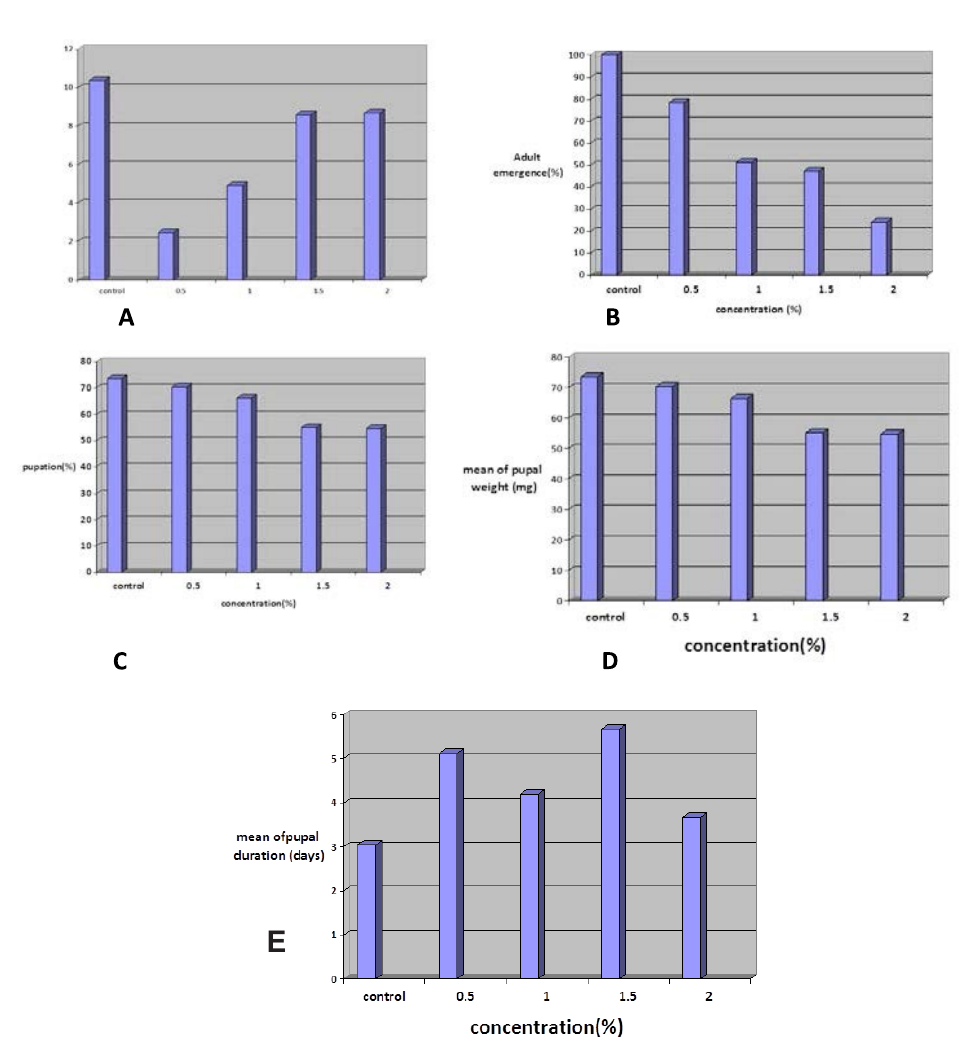
A: Fig. 2. Effect of Different Concentrations of Bacillus thruingiensis israelensis on Larval Life Span ( Days ) of M. Domestica Treated as 2 nd Larval Instar. B: Fig. 3. Effect of Different Concentrations of Bacillus thrringiensis israelensis on the Percentage of Pupation of M. domestica Treated as 2 nd Larval Instar. C: Fig. 4. Effect of Different Concentrations of Bacillus thuringiensis israelensis on the Percentage of Pupation of M. domestica Treated as 2 nd Larval Instar. D: Fig. 5. Effect of Different Concentrations of Bacillus thuringiensis israelensis on Mean of Pupation Weight (mg) of M. domestica Treated as 2 nd Larval E: Fig. 6. Effect of Different Concentrations of Bacillus thuringiensis israelensis on Pupation of M. domestica Treated as 2 nd Larval Instar.